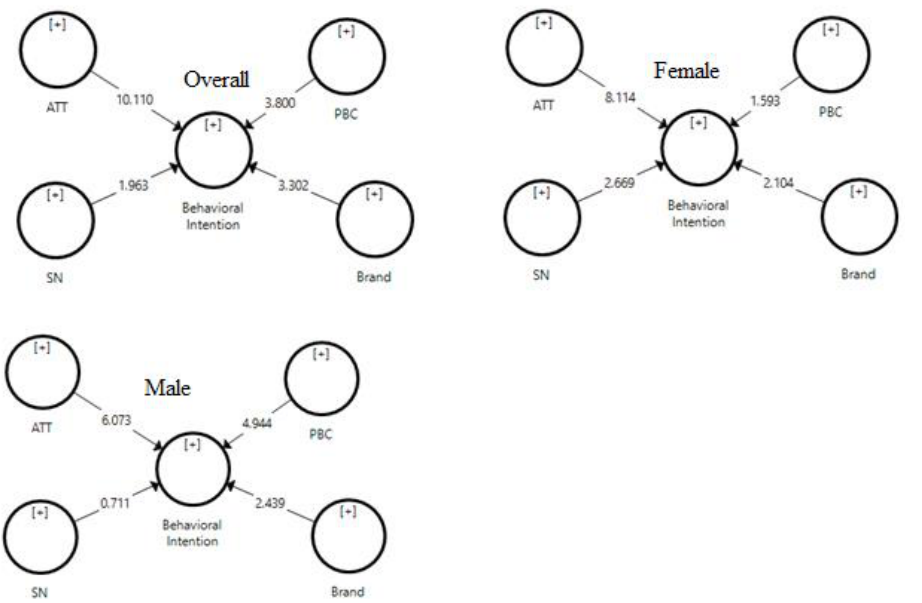
Figure 2. Structural model for overall, female and male groups.